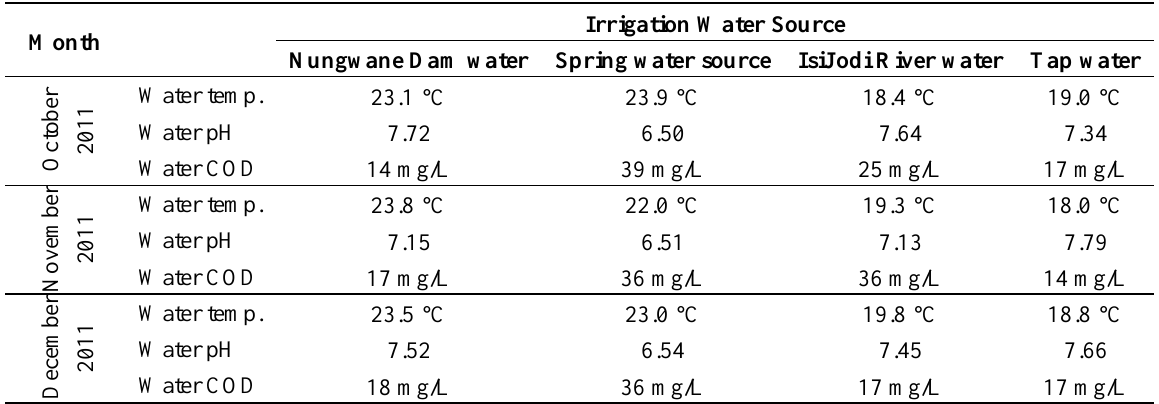
Table 3. Physico-chemical characteristics of irrigation water sources tested in the months of October, November and December